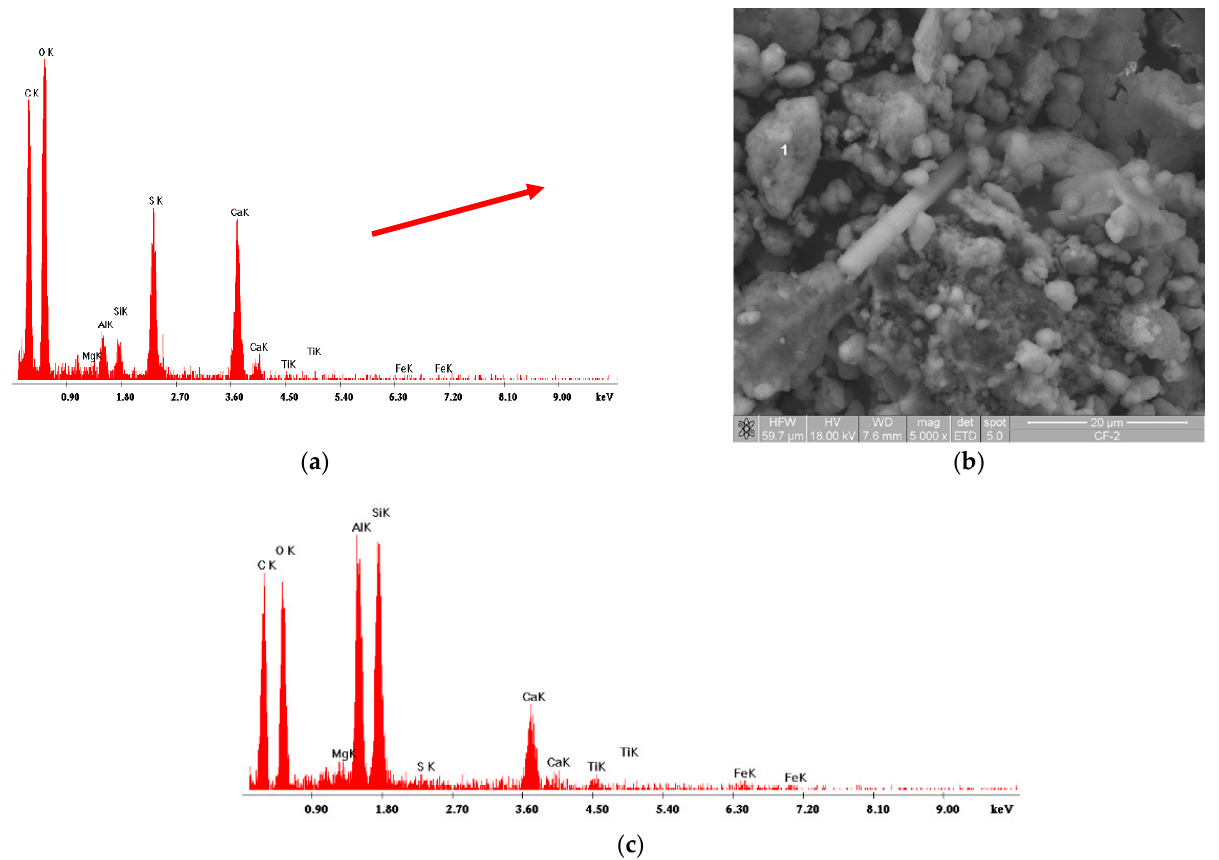
Figure 7. ( a ) Analysis of microareas: Point 1 (EDS); ( b ) Microstructure of the hardened water suspension of FBC fly ash from burning lignite with added CO 2 (SEM); ( c ) analysis of average microareas (EDS).